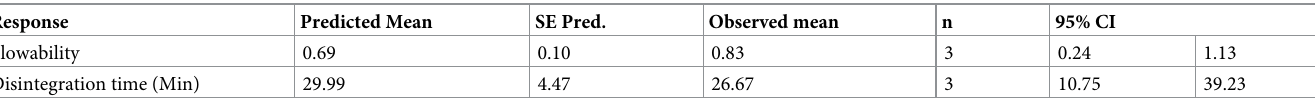
The final optimized granules are brownish, free-flowing, with a sweet smell (Fig 4A). The resultant standardized 600 mg herbal capsule dosage form containing 76.0% dry herbal extract Table 8. Results of confirmation